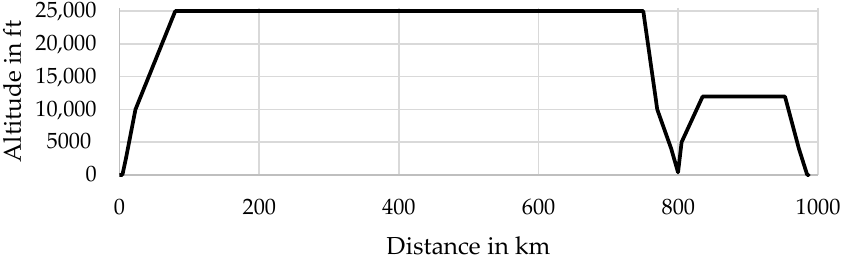
Figure 1. 800 km reference flight mission for the initial sizing calculations. The aircraft’s energy resources must also cover a reserve segment after the regular flight. The flight distance covered within the holding pattern is not shown